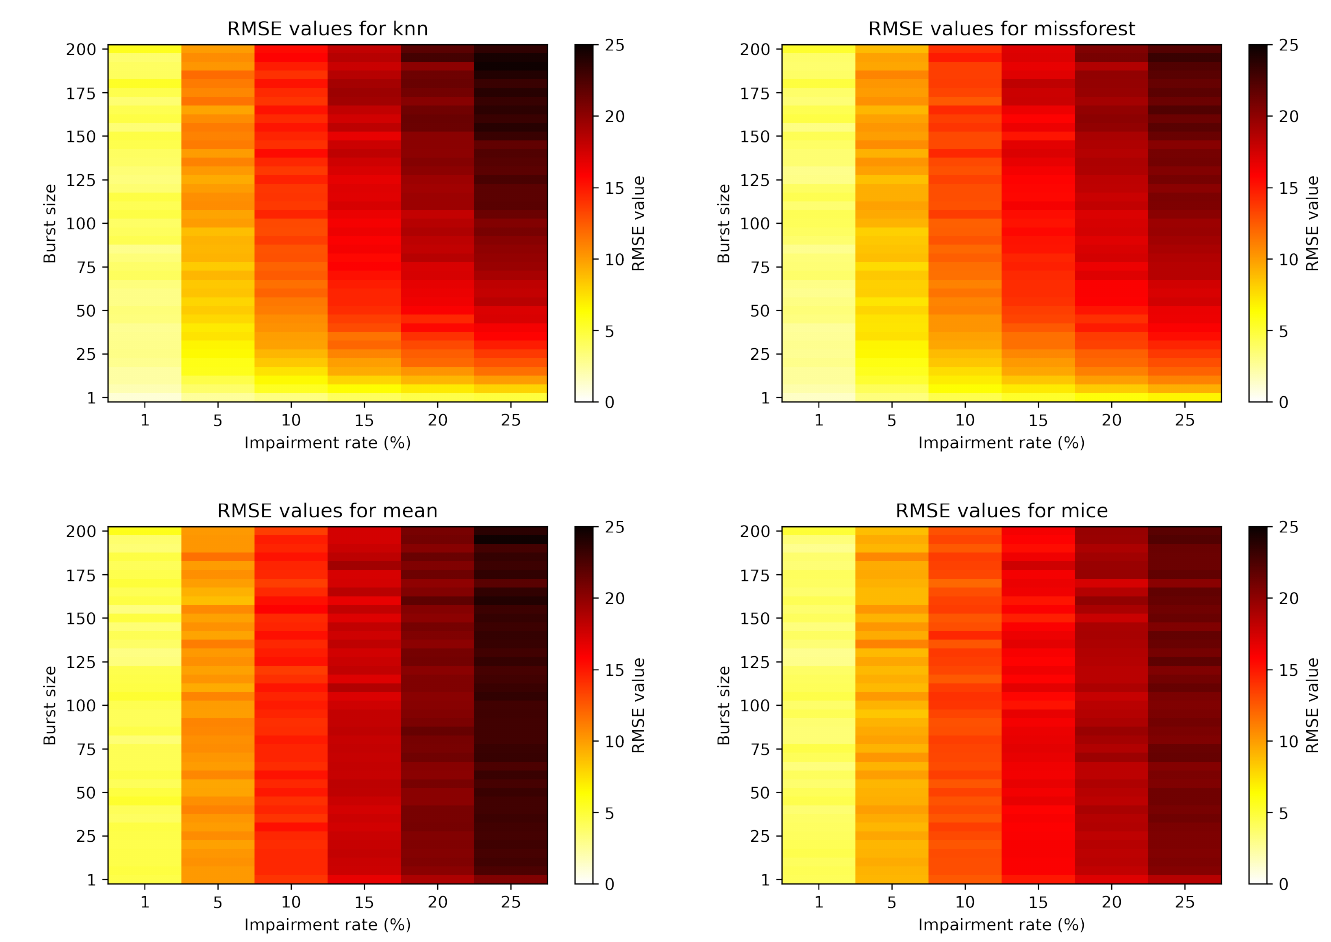
Figure 6. Colormap showcasing the RMSE in relation to the impairment rate and burst